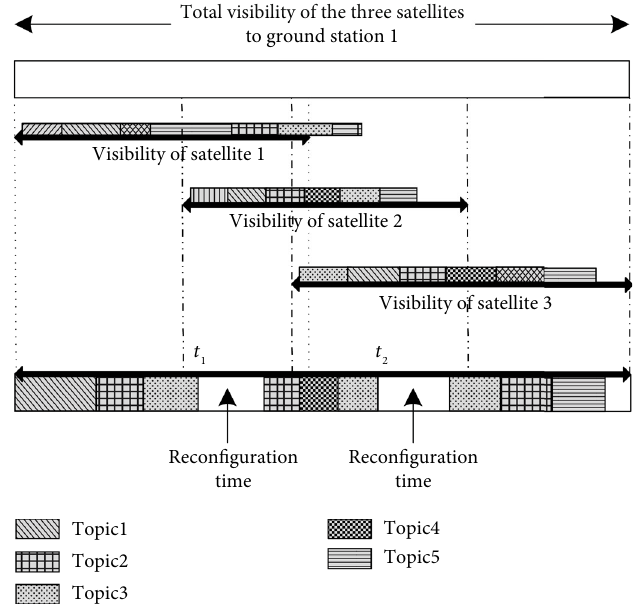
Figure 3: The illustration of data topic typical transmission